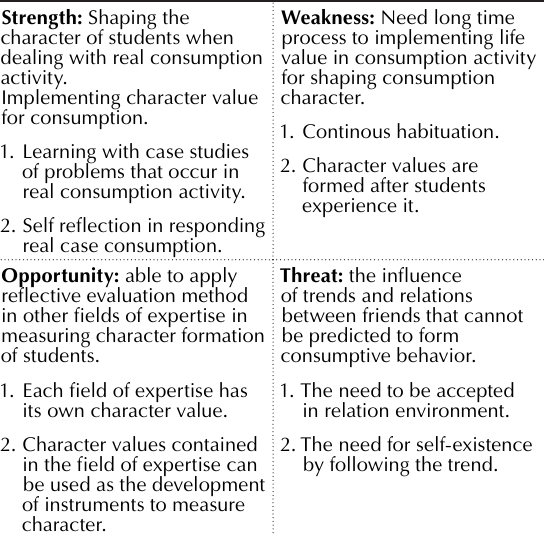
Table 1. SWOT analysis on Consumer